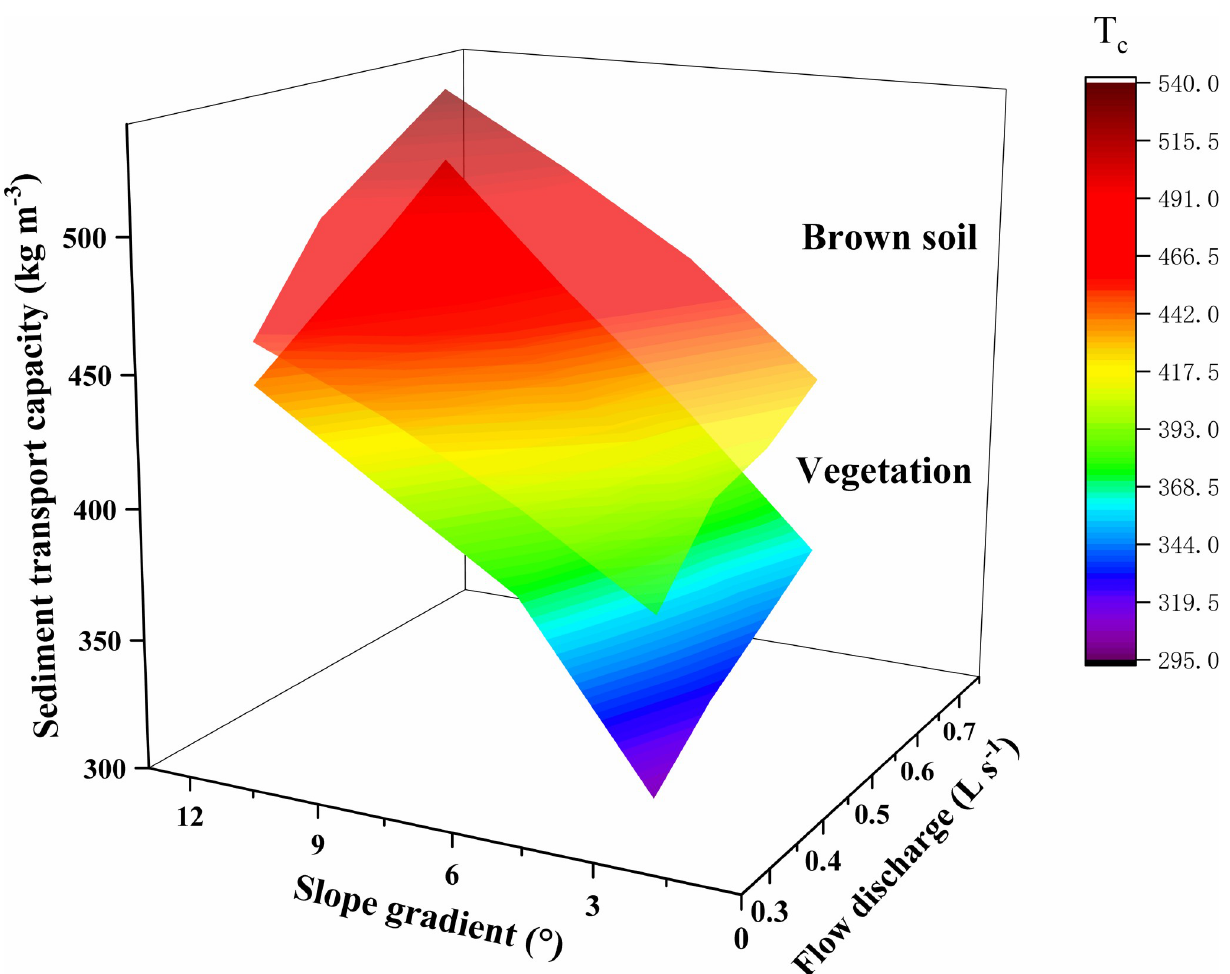
Fig 3. The sediment transport capacity changing the relationship with slope gradients and flow discharge.